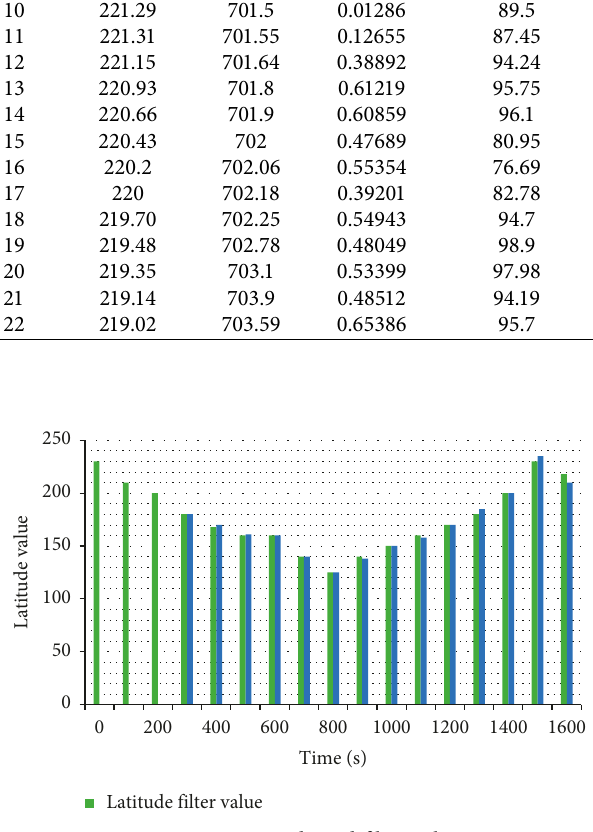
Figure 10: Latitude and filter